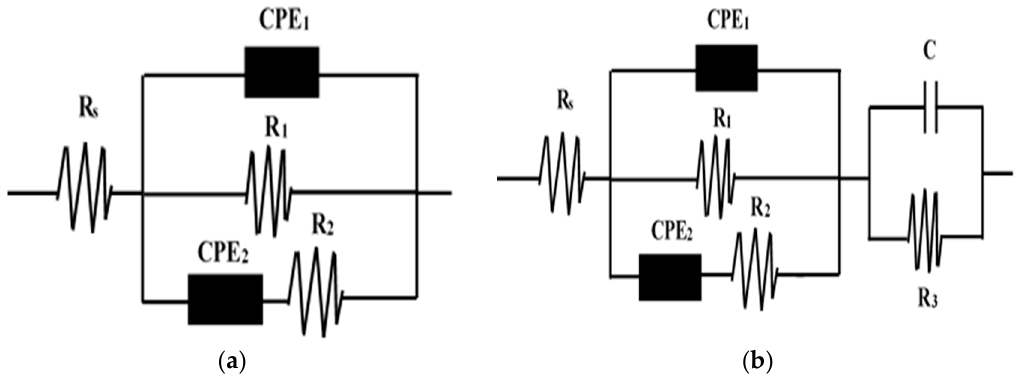
Figure 8. Equivalent electrical-circuit model: ( a ) the original state of corrosion in 3.5% NaCl solution, ( b ) corrosion state after a certain period of time in 3.5% NaCl solution.